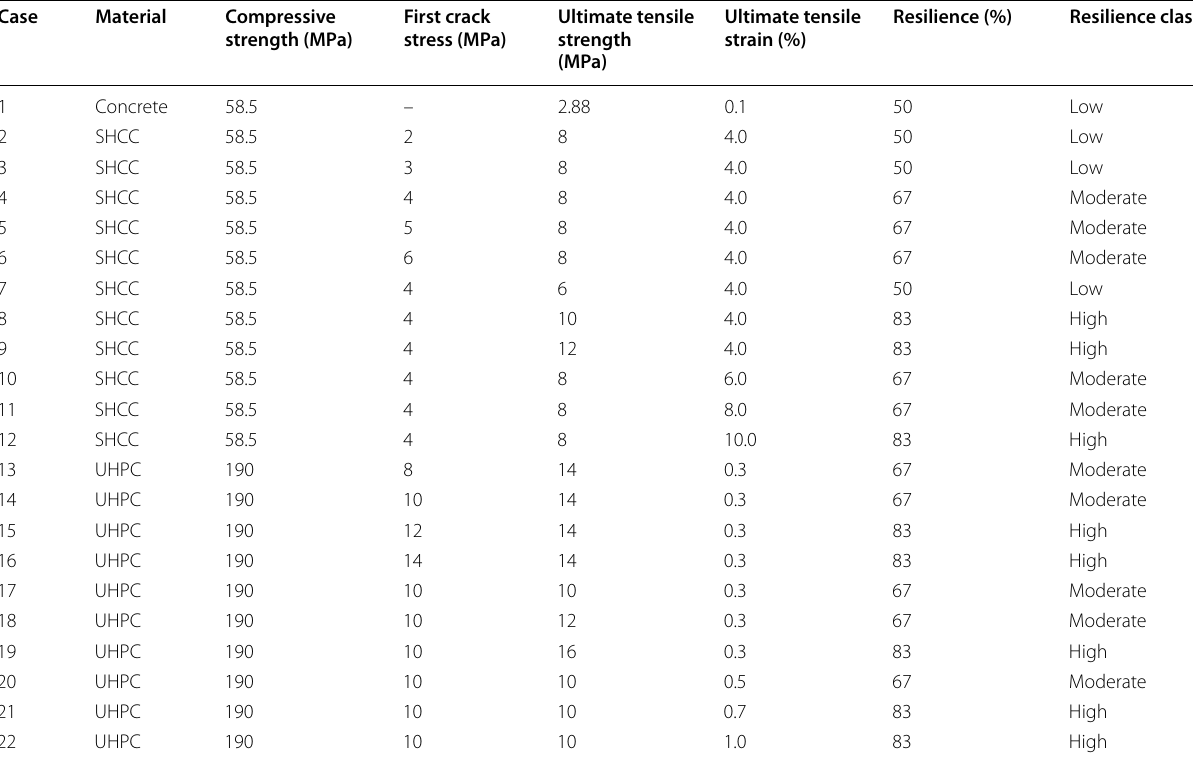
Table 3 Summarization of resilience results in parametric study